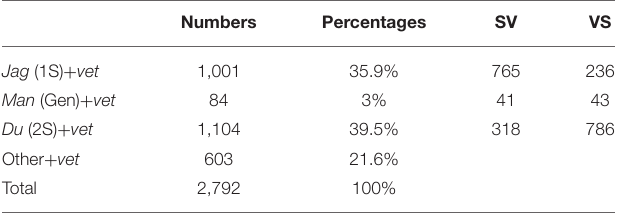
TABLE 3 | Co-distribution of egophoric pronouns and vet